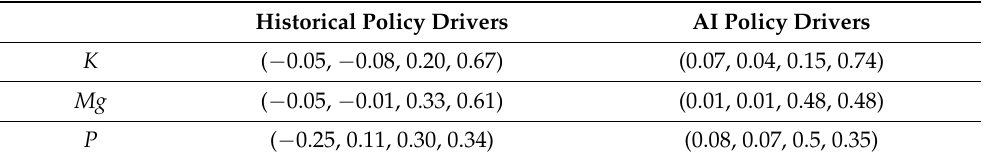
Table 3. Weights of four variables driving electrolyte repletion (IV repletion cost, PO cost, abnor- mally high, and abnormally low electrolyte values) in the historical dataset and after application of reinforcement learning (RL) algorithm showed substantial changes.